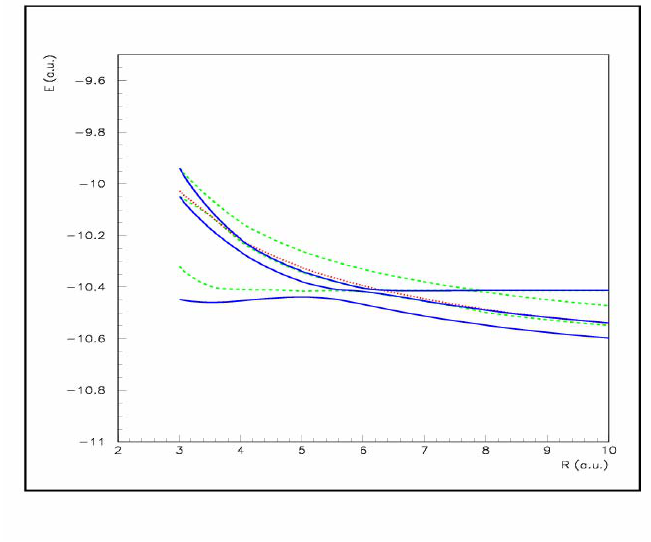
Figure 7: Adiabatic potential energy curves of SHe 3+ ; ________ 2 Π states; ________ 2 Σ